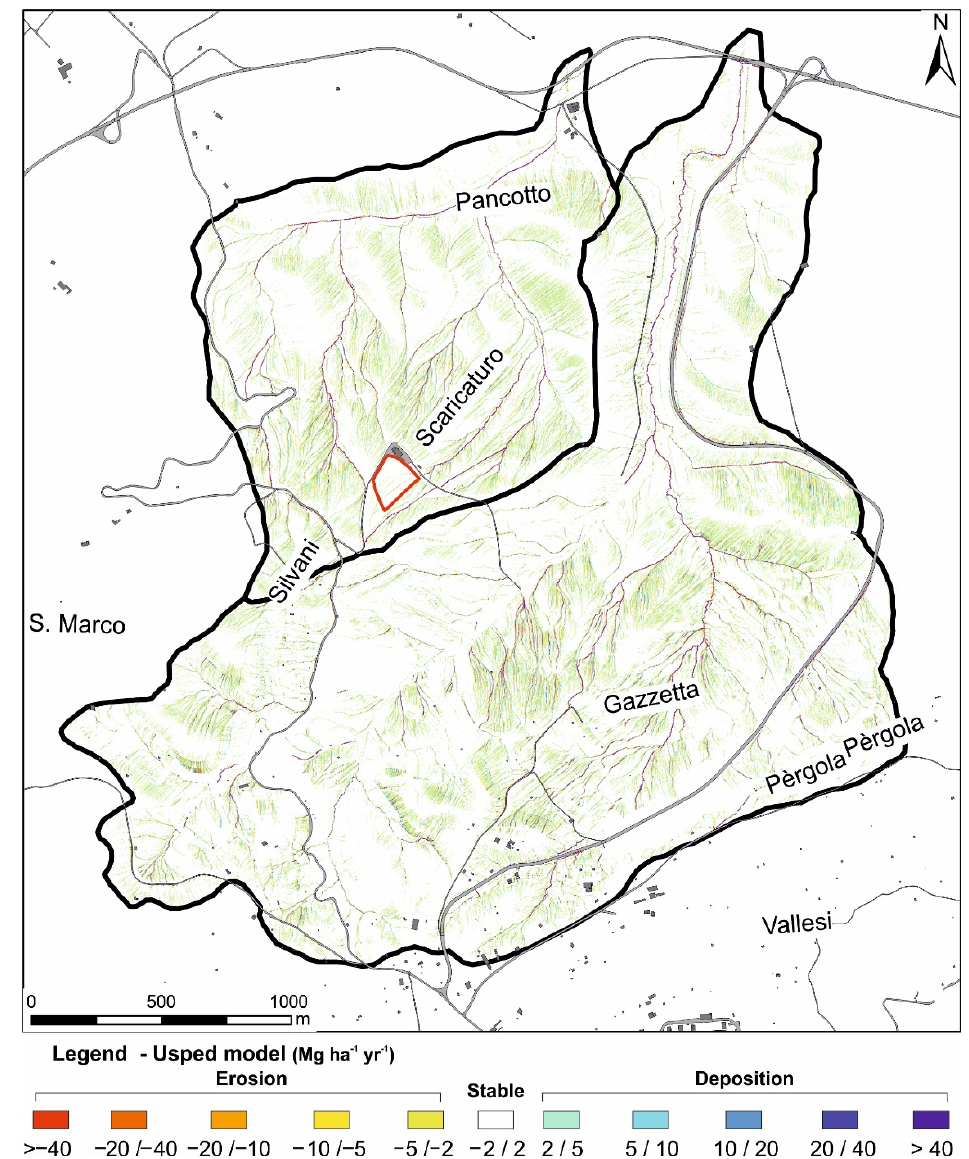
Figure 6. Mean annual soil erosion of the study area as inferred by the USPED model. The red square indicates the hazelnut crop area.